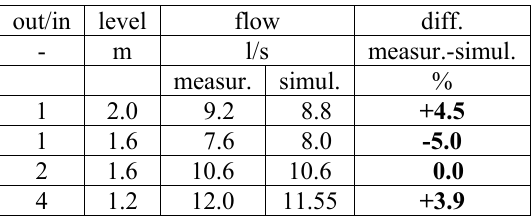
Table 5-1. Simulations compared with measurements (inlet 80